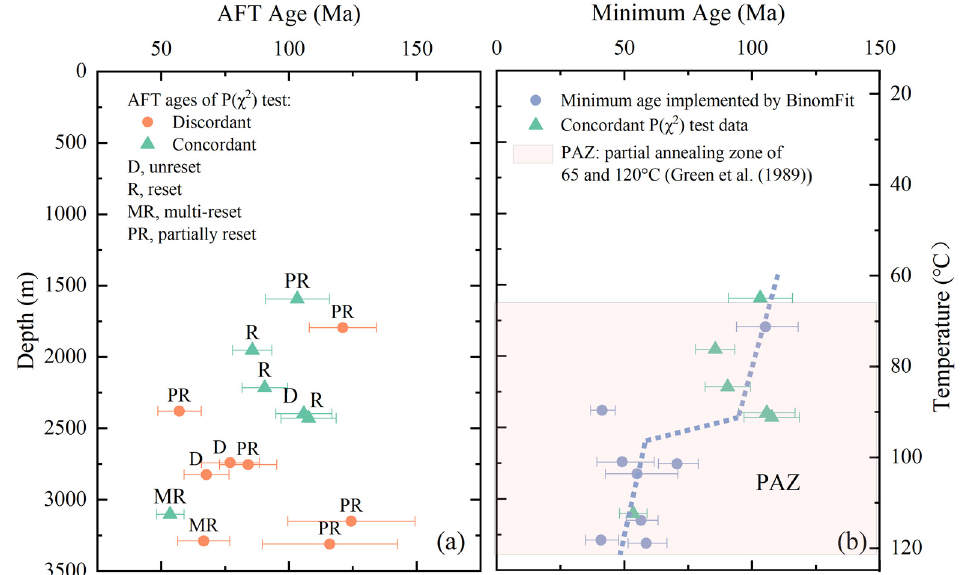
Figure 5. Age–depth relationship for apatite fission-track ages from the Linqing Depression. ( a ) Central or pooled ages of apatite fission track. ( b ) Minimum ages decomposed by BinomFit. The trend line is shown in grey. “T” signs from dots is errors of ages.